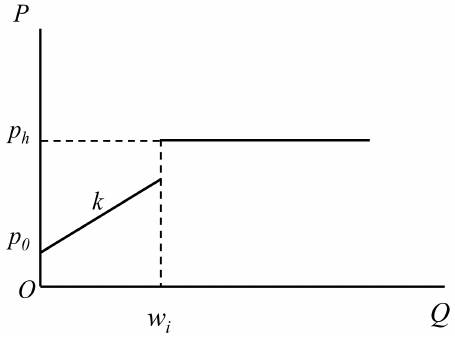
Figure 3. Water price ladder